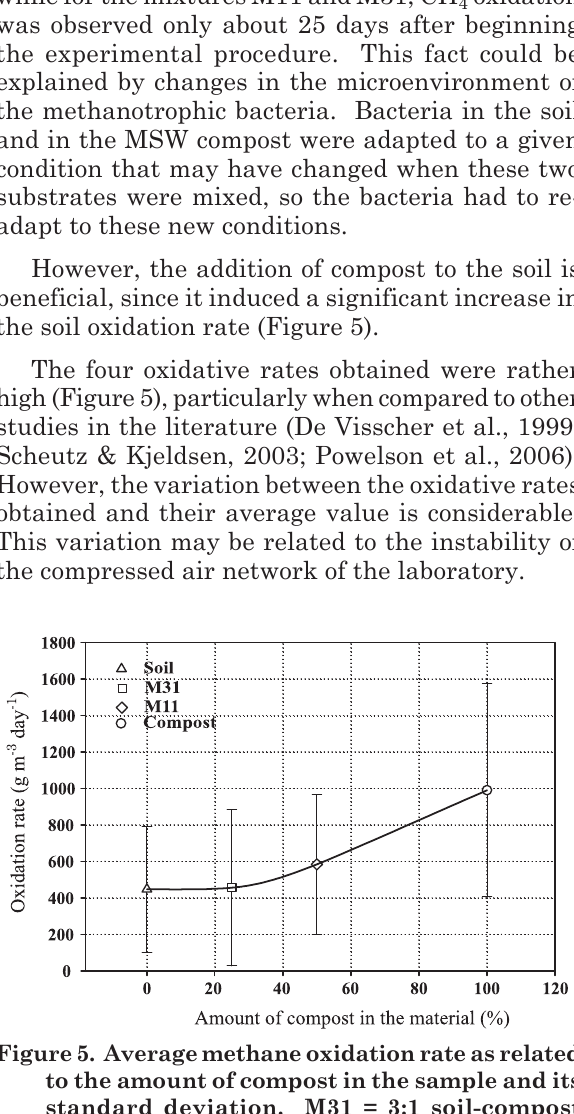
figure 6. Biofilter efficiency versus the amount of compost in the